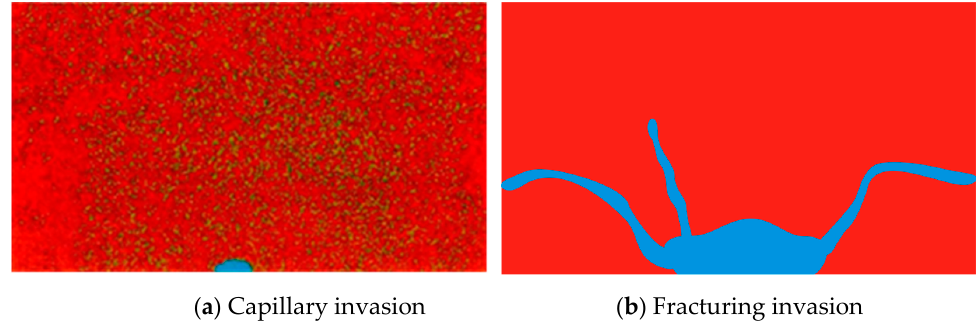
Figure 2. CT scanning results of gas invasion in